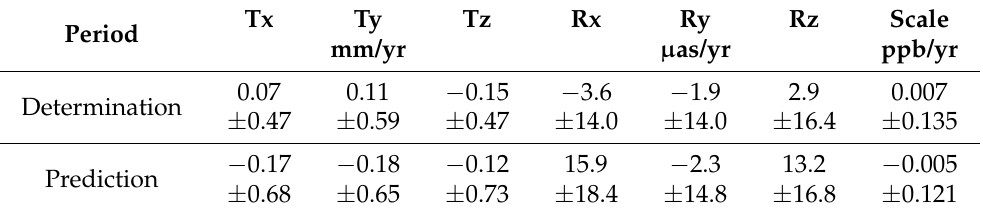
Table 2. The drifts and standard deviations of the transformation parameter time series estimated between DTRF2014 and IGS before and after 2015.0. Note: the standard deviation of scale was the result after the annual signal with an amplitude 0.25 ppb